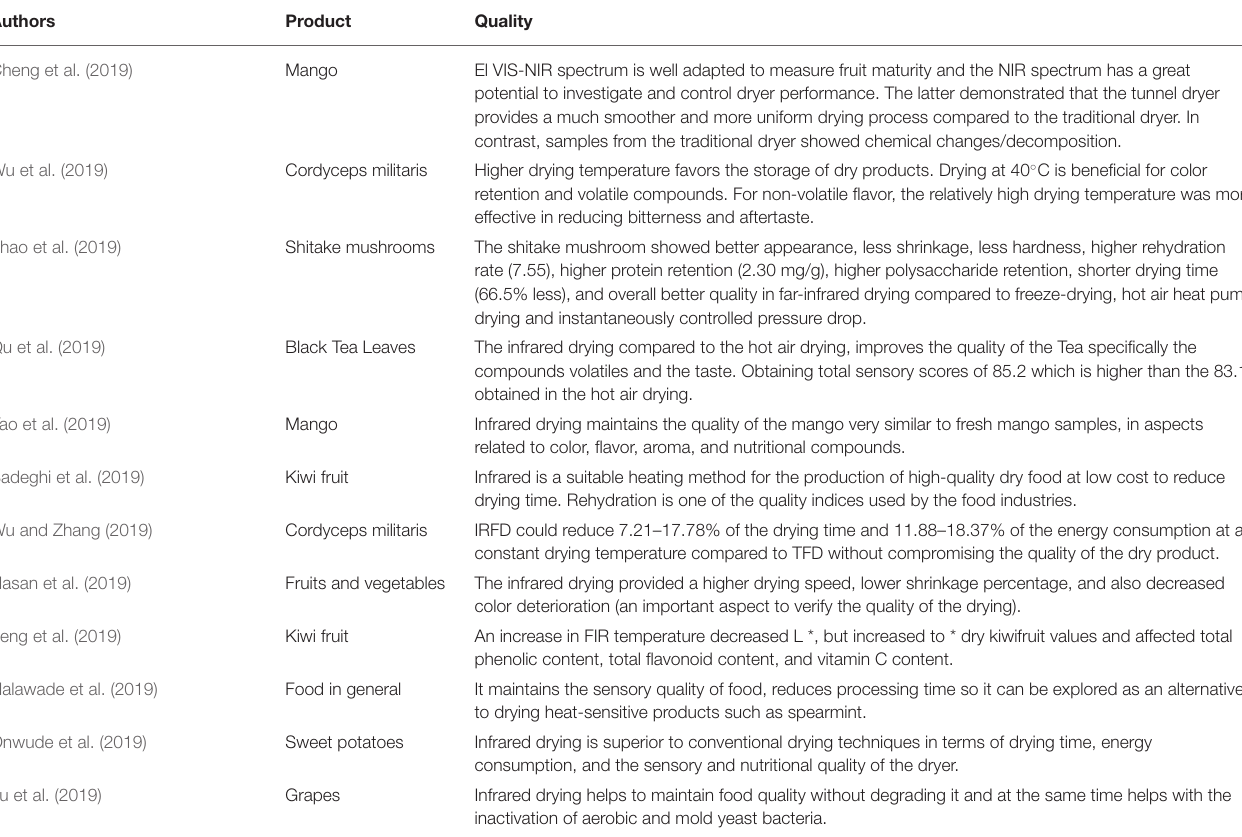
TABLE 3 | Effects on the quality of infrared drying.